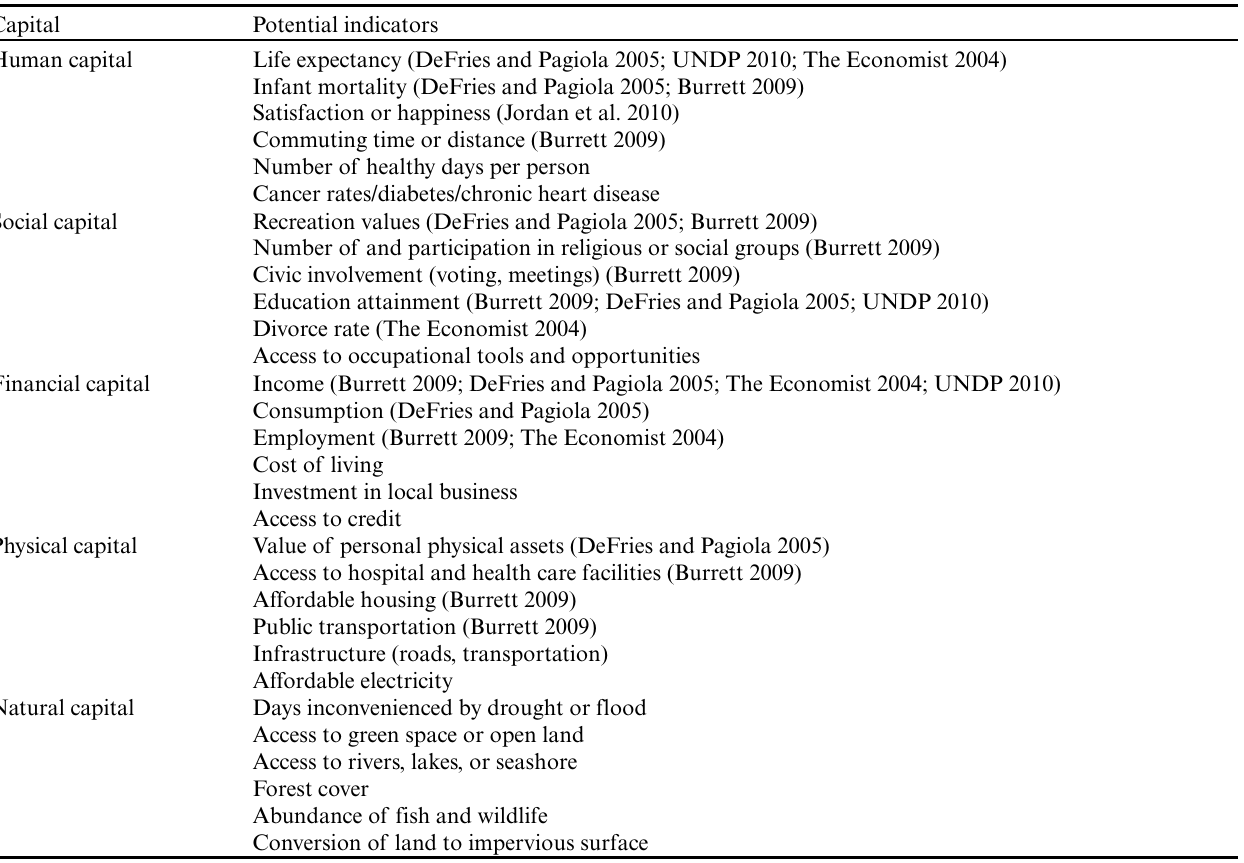
Table 3 . Capital components of the Sustainable Livelihoods Framework and potential indicators presented to stakeholders in Albemarle- Pamlico watershed (North Carolina and Virginia,